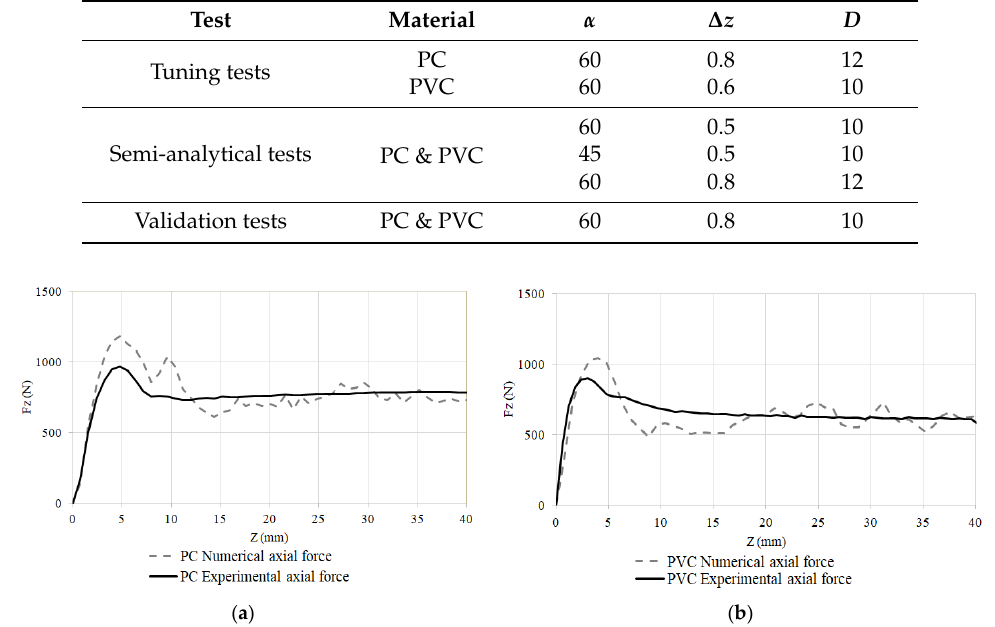
Figure 7. Numerical and experimental axial force profile. ( a ) PC process conditions: Cone shape, α = 60°, D = 12 mm and Δz = 0.8 mm; ( b ) PVC process conditions: Cone shape, α = 60°, D = 10 mm and Δz = 0.6 mm.